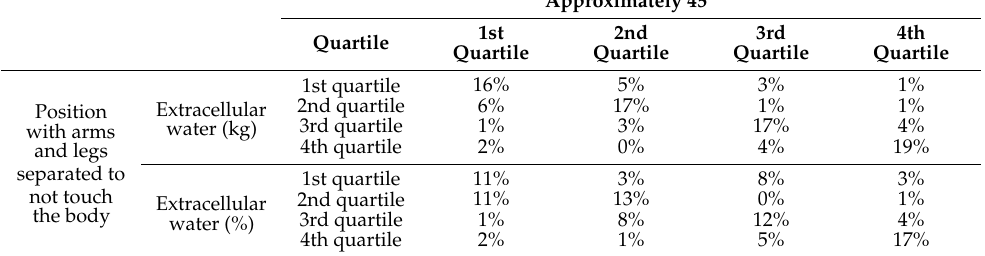
Table 4. Analysis of the quartile distribution of the extracellular water results in the studied group of Caucasian young normal body mass women measured in the follicular phase in various positions (with arms abducted at least 30 ◦ and legs abducted at approximately 45 ◦ ; with arms and legs separated to not touch the body). Position with Arms Abducted at Least 30 ◦ and Legs Abducted at Approximately 45 ◦ 1st Quartile